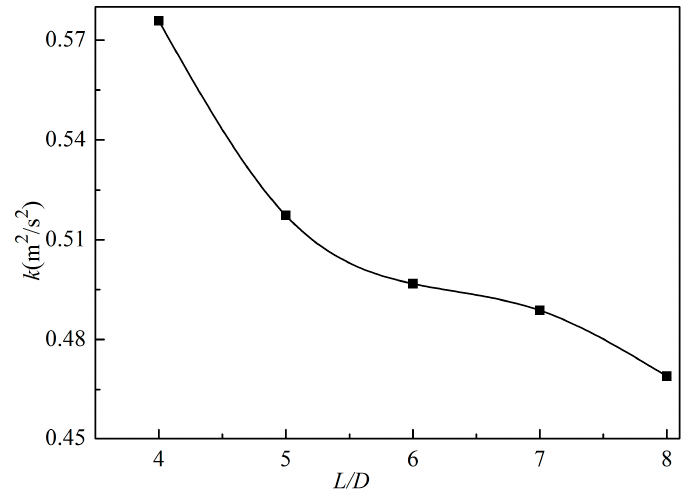
Figure 18. Effect of L / D on the mean k of the impingement region in one period by CFD at u m = 1.25 m/s, A = 0.25 m/s, T = 0.4 s and ∆ ϕ = T /2 for sinusoidal inlet velocity.